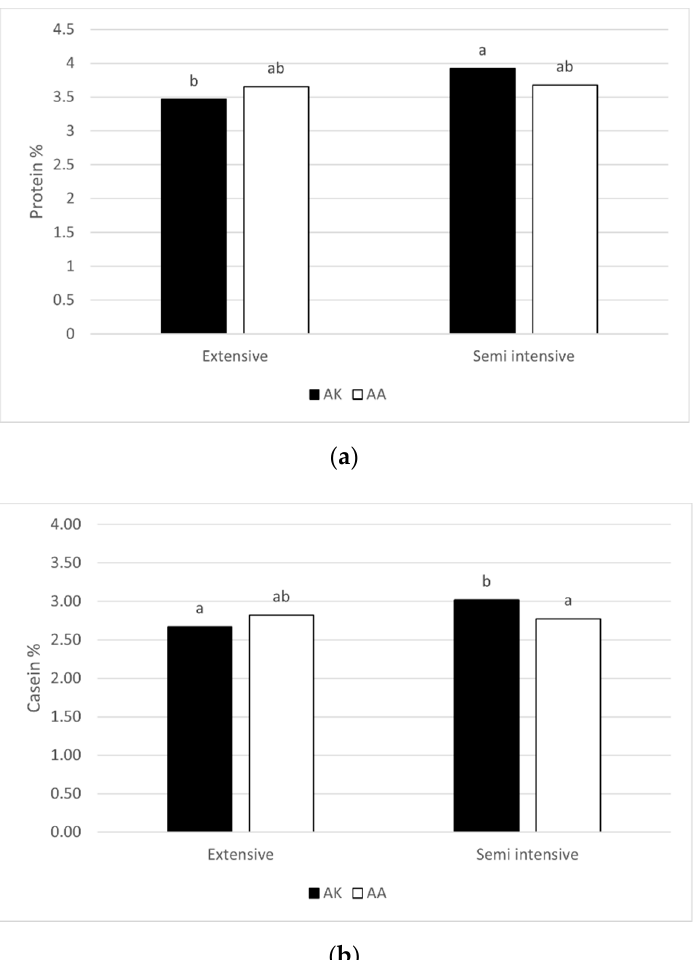
Figure 1. Effect of the interaction between genotype at DGAT1 K232A (AK and AA) and feeding system (extensive and semi-intensive) on protein ( a ) and casein ( b ) percentages in Modicana cow milk; a,b Different superscript letters indicate differences ( p ≤ 0.05) between mean values tested by Tukey’s multiple comparison test. Table 2. Effects of DGAT K232A genotype and feeding system on mean milk fatty acid composition. Milk Fatty Acids % of Total Fatty